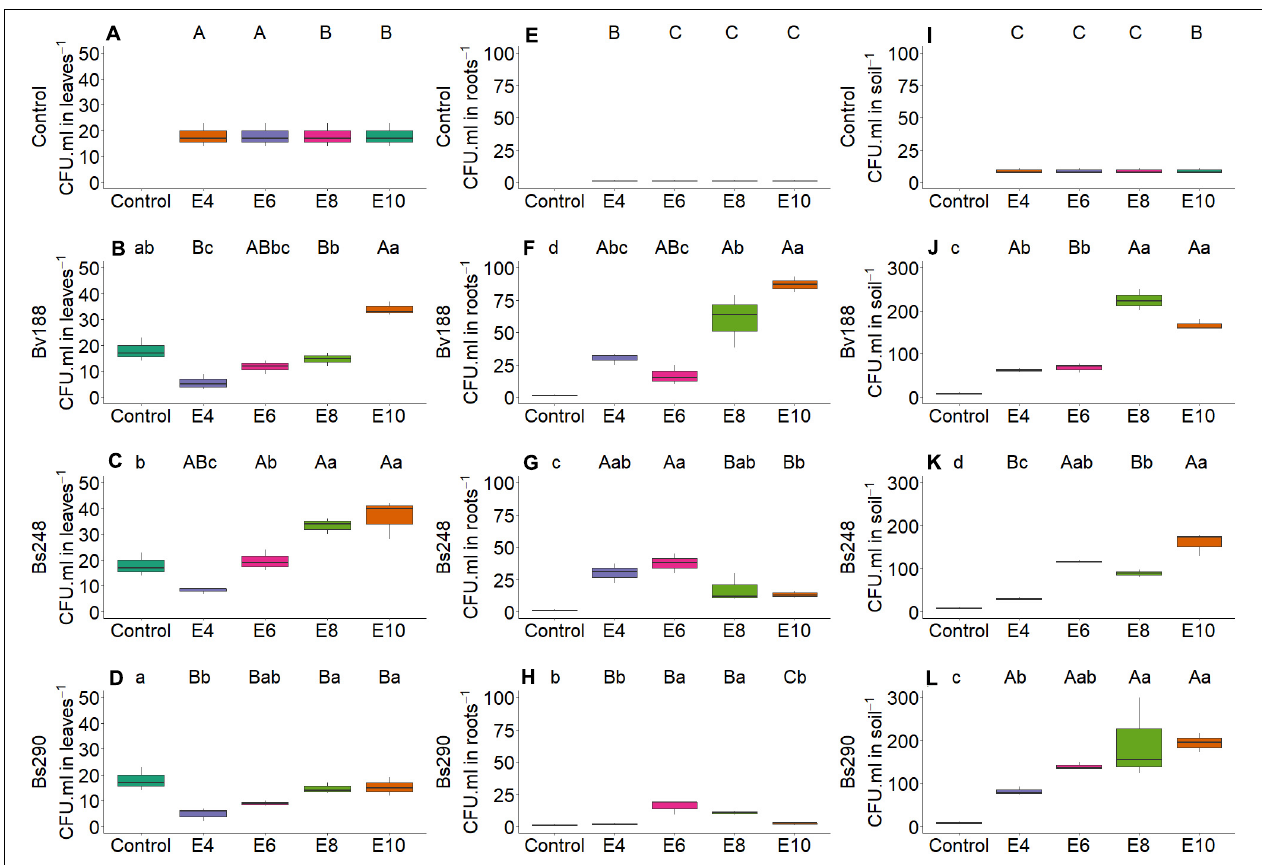
FIGURE 8 | Boxplots (median and quartiles) of CFU in leaves (A–D) , root (E–H) , and soil (I–L) inoculated with plant growth-promoting microorganisms. Different lowercase letters in a row and uppercase letters in the vertical indicate statistical difference between means (Tukey, p < 0.05). Bv188, Bacillus velezensis strain Bv188; Bs248, Bacillus subtilis strain Bs248; Bs290, B. subtilis strain Bs290; E4, 1 × 10 4 ; E6, 1 × 10 6 ; E8, 1 × 10 8 ; E10, 1 × 10 10 conidia or CFU mL − 1 ; Ctrl, control; CFU, colony-forming